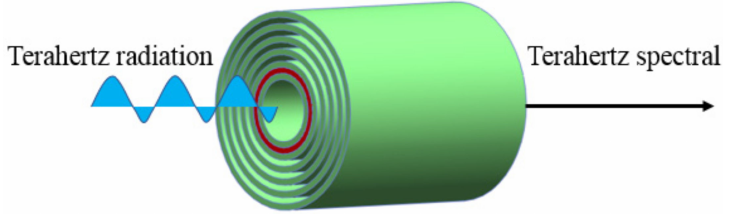
Figure 1. 3D view of the proposed fiber where terahertz (THz) radiation impinges at the center of the